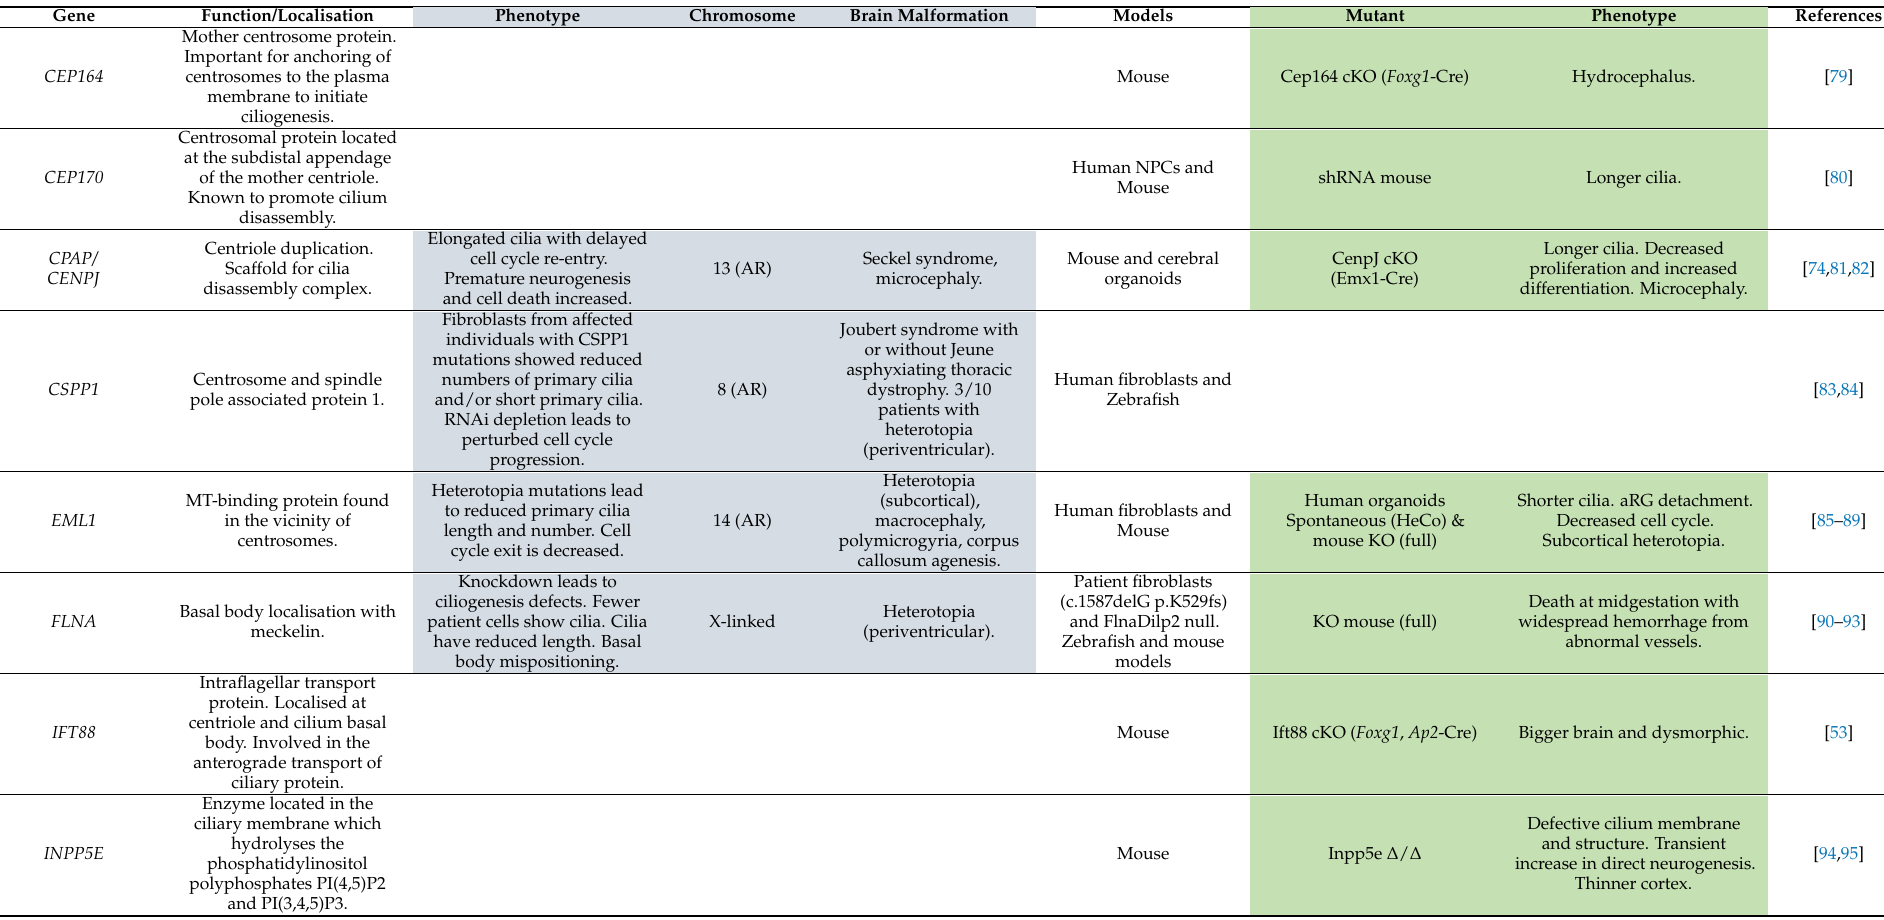
Defective cilium membrane and structure. Transient increase in direct neurogenesis. Thinner